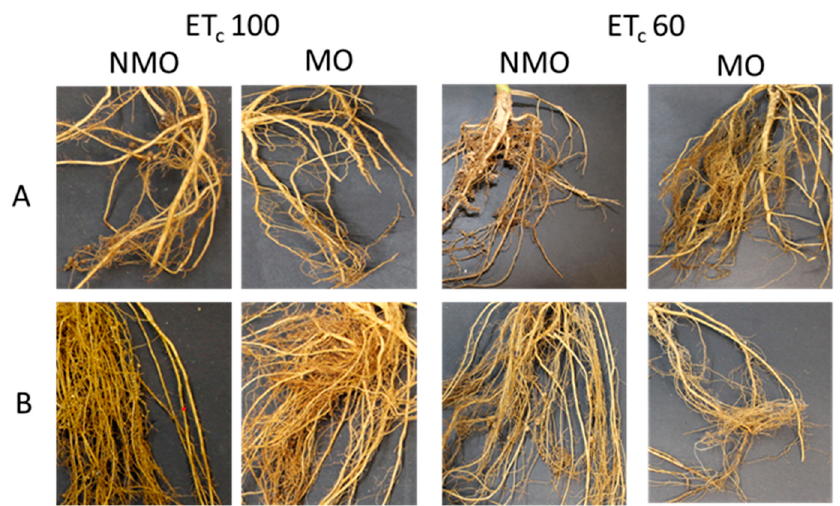
Figure 3. Yield cumulative curves. ( A ) yield of all harvest expressed in kg m -2 ; ( B ) percentage of yield collected per harvest.